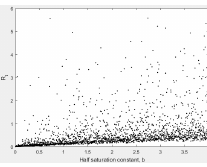
Figure 5. The scatter plot is Figure 6. The scatter plot is having a pattern indicating that the having a visible pattern indicating correlation between R t and b is that the correlation between R t and a strong implying that R t is most is strong implying that R t is also very sensitive to b . sensitive to a